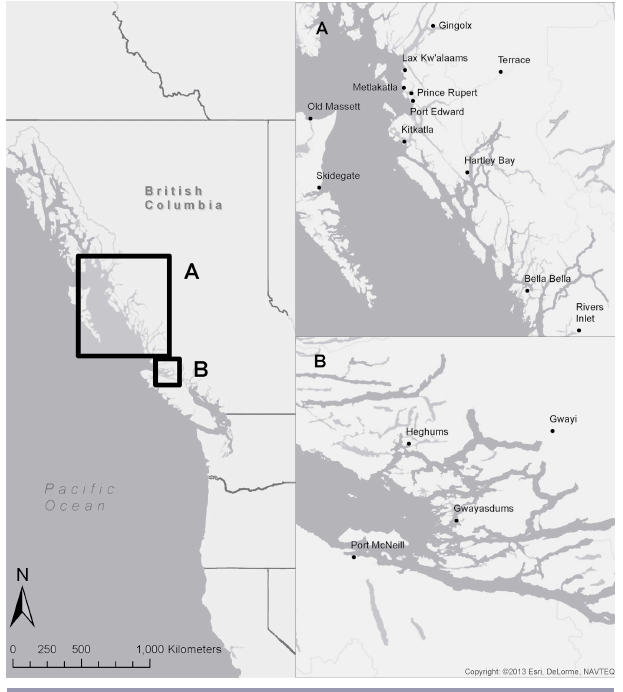
Fig. 1 . Coastal British Columbia areas represented by Sustainable Marine Fisheries and Communities Alliance (A) and Musgamagw Dzawada’enuxw Tribal Council